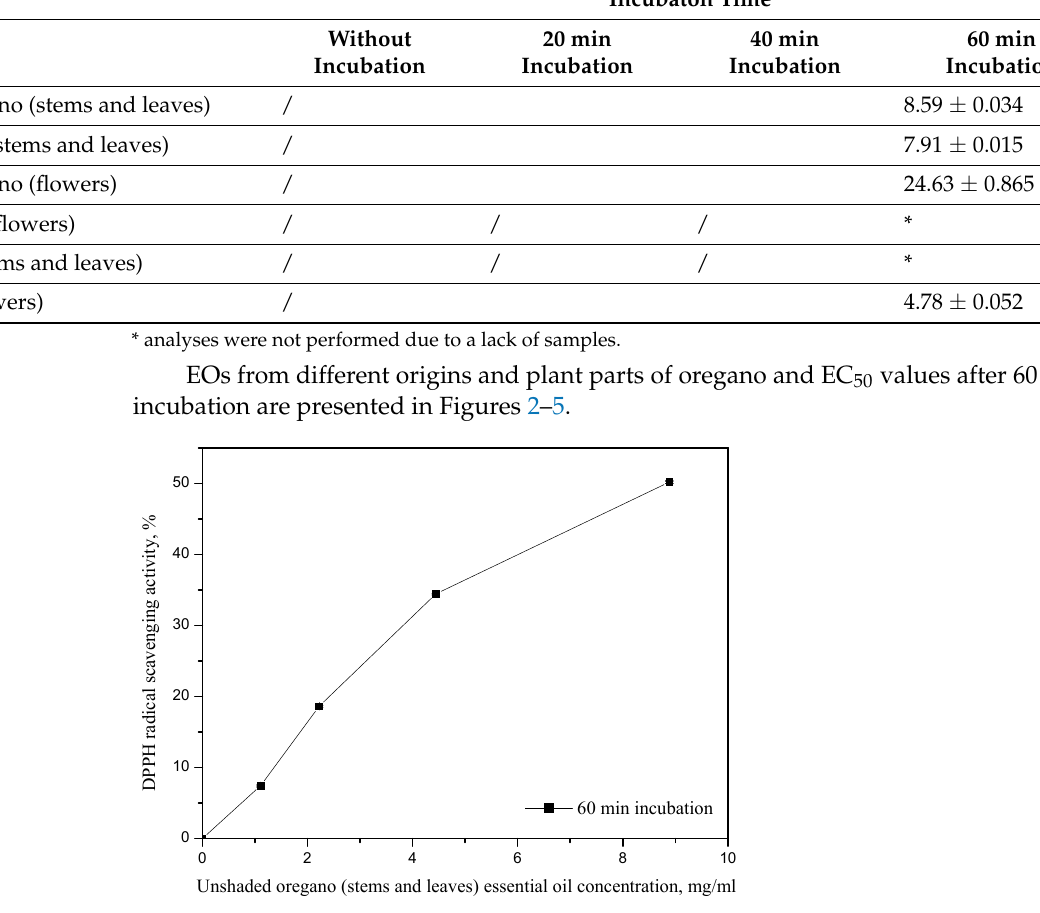
Figure 3. Antioxidant activity of shaded oregano (flowers) essential oil.